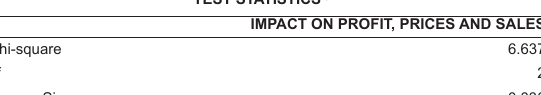
TABLE 21 Robust tests of equality of means (question 11)